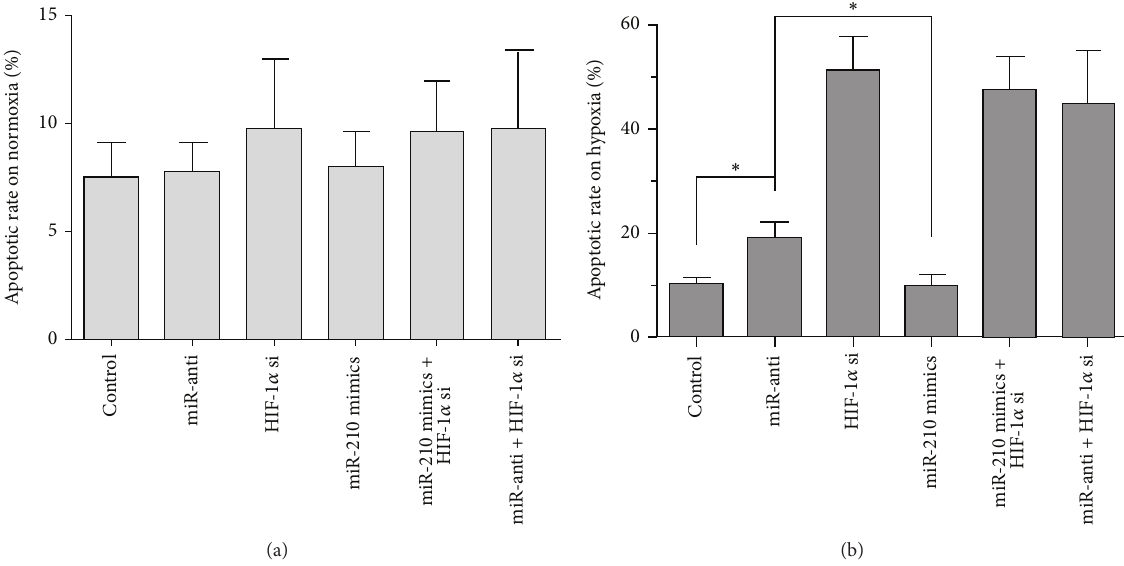
Figure 5: Downexpression of miR-210 increased apoptosis via HIF-1 𝛼 in hypoxic C28/I2 cells. Apoptosis of C28/I2 cells transfected with miR-210 mimics, miR-anti, or HIF-1 𝛼 si was measured by flow cytometry after 48h upon hypoxia or normoxia. (a) Apoptotic rate in C28/I2 cells on normoxia. (b) Apoptotic rate in hypoxic C28/I2 cells. Three individual experiments were conducted. The significant differences were denoted as ∗ 𝑃 < 0.05